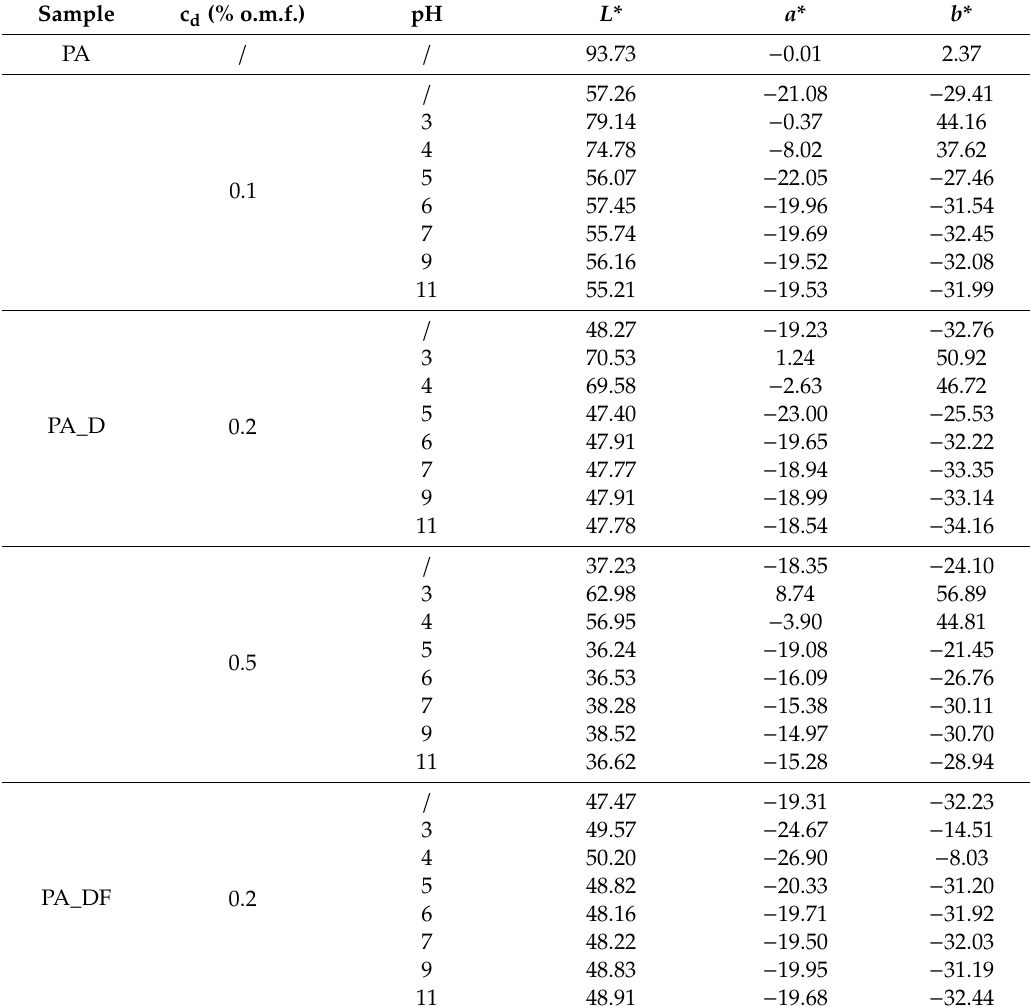
Table 1. The CIELAB colour values of undyed (PA), unfinished dyed (PA_D), and finished dyed (PA_DF) samples with di ff erent dye concentrations (c d ) before and after exposure to bu ff er solutions of di ff erent pH values.